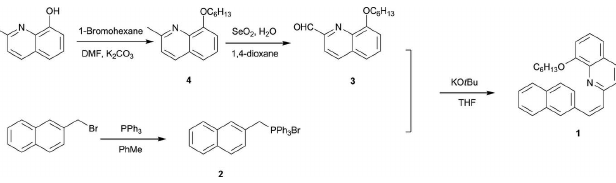
Figure 3 Synthetic procedures for ( Z )-8-(hexyloxy)-2-[2-(naphthalen-2-yl)ethen- yl]quinoline ( 1